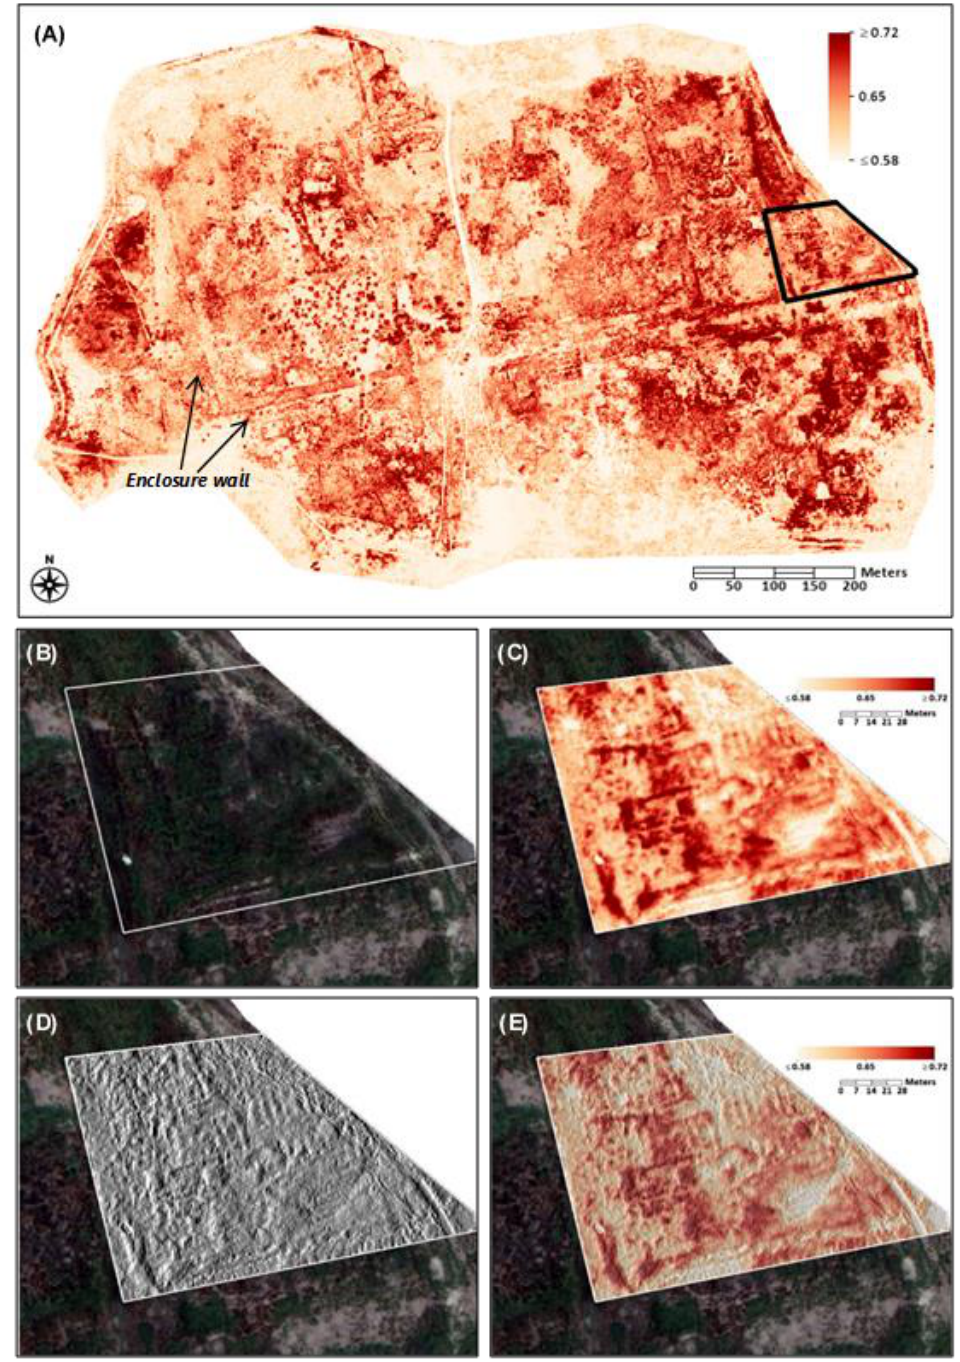
Figure 5. Infrared Percentage Vegetation Index (IPVI) for the entire study area with the detected site highlighted in the black box (A). WV-3 true color image showing the area covered by surface vegetation (B). Dense network of archaeological structures revealed by IPVI. The high IPVI value (0.7) indicates enhanced vegetation health atop the sub-surface linear features (C). Linear features are visible using edge-detection spatial filtering (D). IPVI overlaid onto the edge detection in order to accentuate the buried linear structures (E).